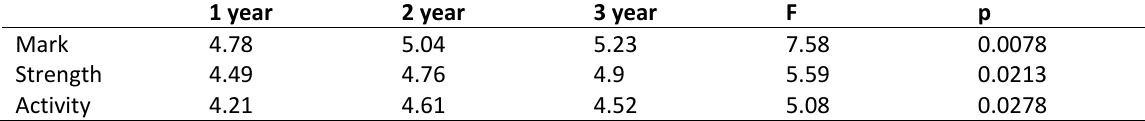
Table 3. Comparison of mark, strength and activity of images of future health basics